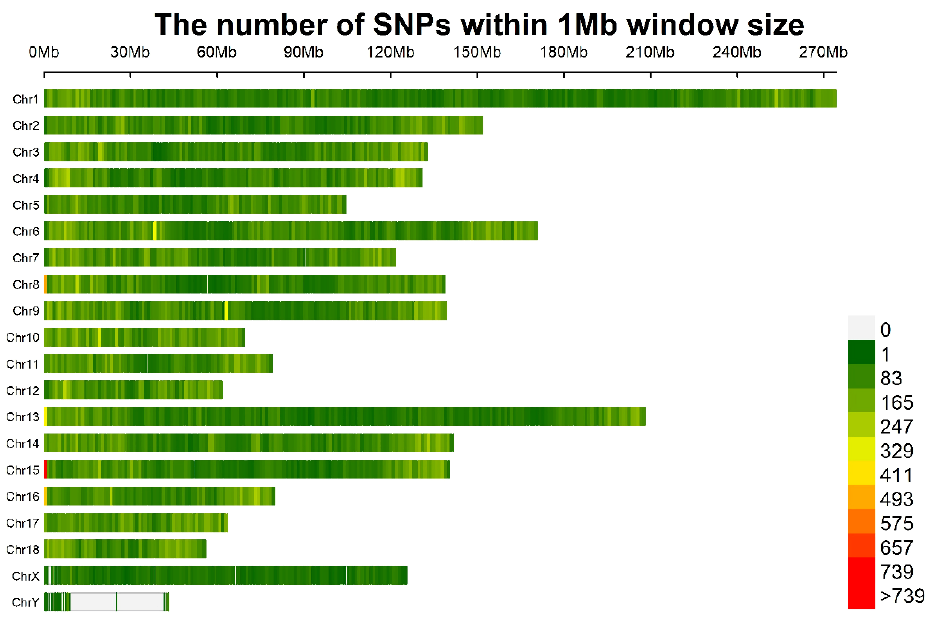
Figure 2. The filtered SNP density distributions on Sscrofa chromosomes. The horizontal axis ( x -axis) shows the chromosome length (Mb). Color index indicates the number of labels.